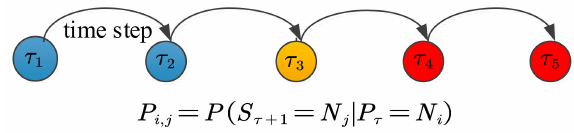
Figure 7. State transitions of the fused values of six water quality parameters at the moment τ